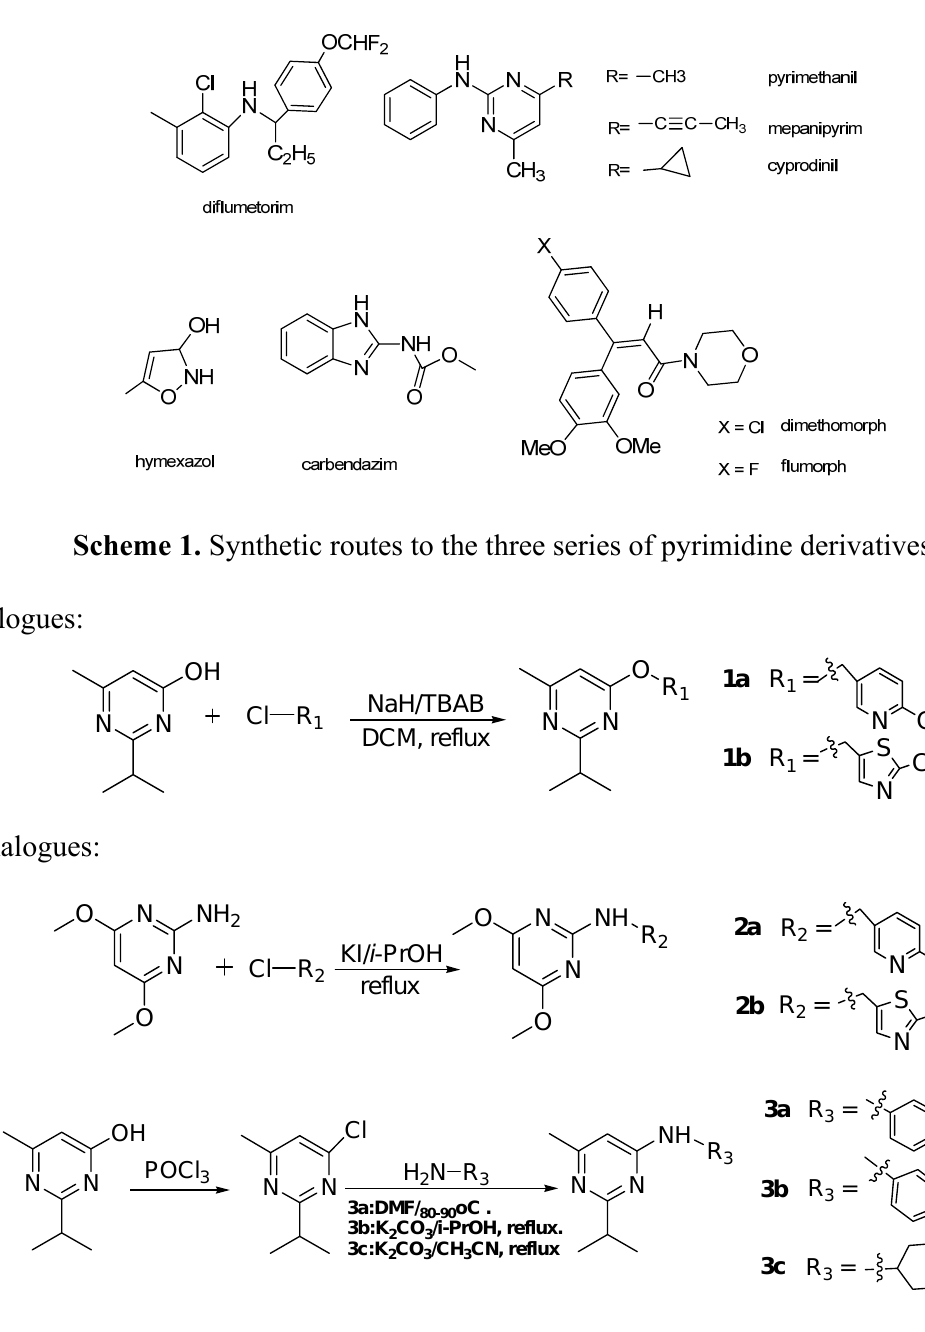
Figure 1. Chemical structures of several commercial